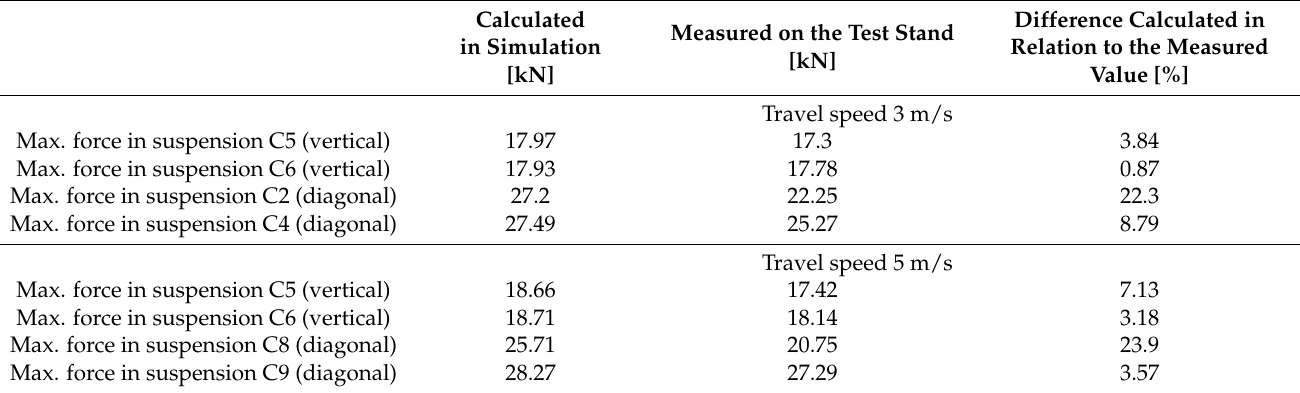
Table 1. Maximum forces in each route suspension